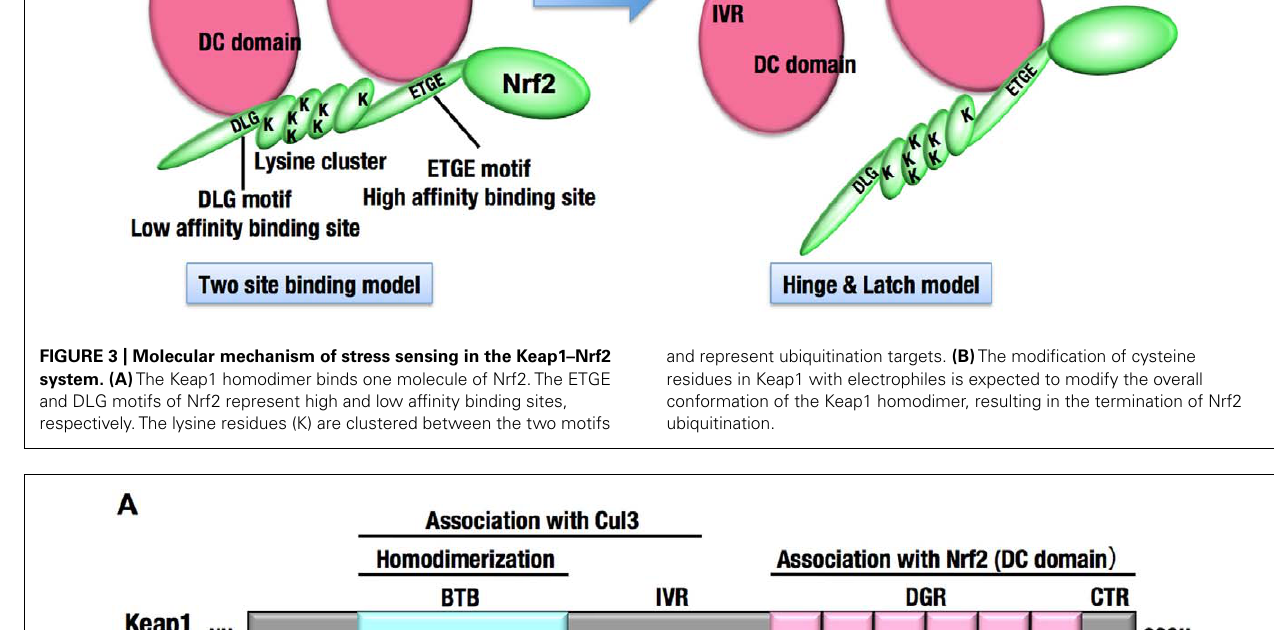
FIGURE 3 | Molecular mechanism of stress sensing in the Keap1–Nrf2 system. (A) The Keap1 homodimer binds one molecule of Nrf2.The ETGE and DLG motifs of Nrf2 represent high and low affinity binding sites, respectively.The lysine residues (K) are clustered between the two motifs